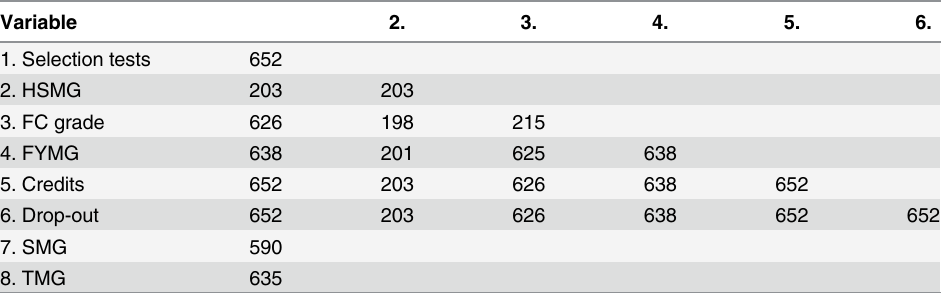
635 Sample sizes for each variable are on the diagonal, sample sizes for combinations of variables are off- diagonal. HSMG, high school mean grade; FC grade, fi rst course grade; FYMG, fi rst year mean grade; SMG, statistics courses mean grade; TMG, theoretical courses mean